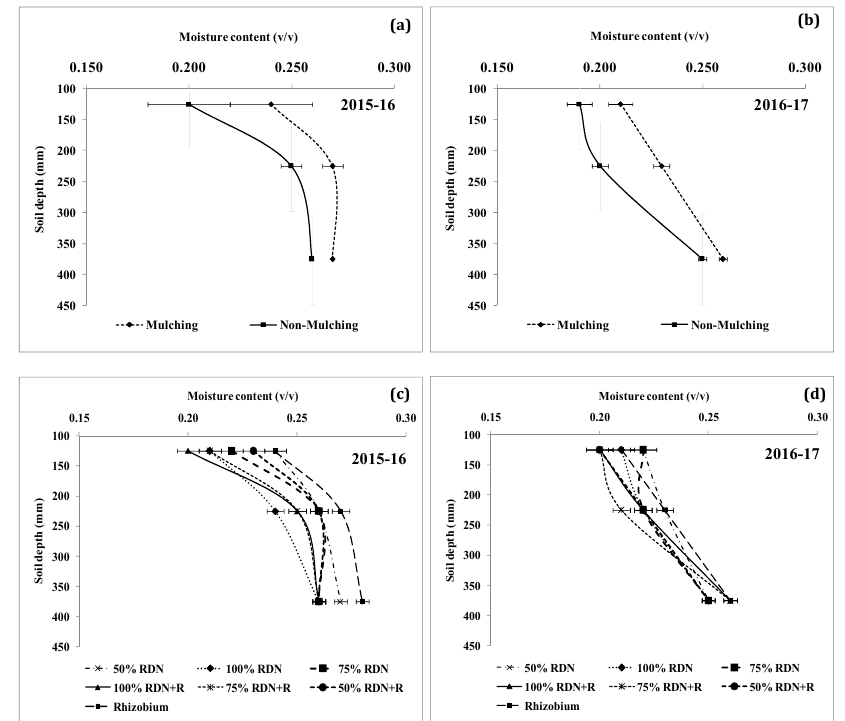
Figure 4. Effect of mulch ( a , b ) and nutrient dose ( c , d ) on soil moisture content ( v / v ) at pegging stage of peanut (data of 2015–2016 and 2016–2017 crop seasons, respectively); error bars represent the least significant difference value.